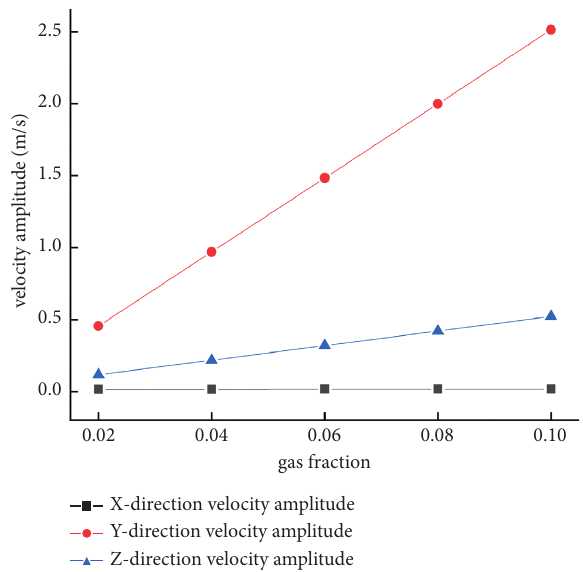
Figure 14: Variation curve of velocity amplitude in different directions with natural gas